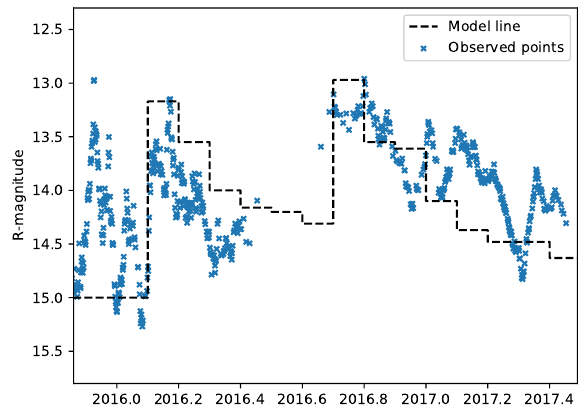
Figure 5. Simulation of the response of the accretion disk to the crossing of the secondary black hole through the disk before the 2015 bremsstrahlung flare. Particles which escape the disk are counted, and they are placed on the time axis assuming that the particle contributes to the light curve after traveling the distance of ∼ 15,000 AU with a constant speed of 0.22 c where c is the speed of light. The exact value of travel distance depends on the radial distance from the center where the particle is released from the disk. The particle count in each time box ( time 2) is turned into a magnitude, assuming that the relation between the particle number and the total brightness in each box is linear. The first flare in observations at the end of 2015 is different (impact flare) and is not modeled by this